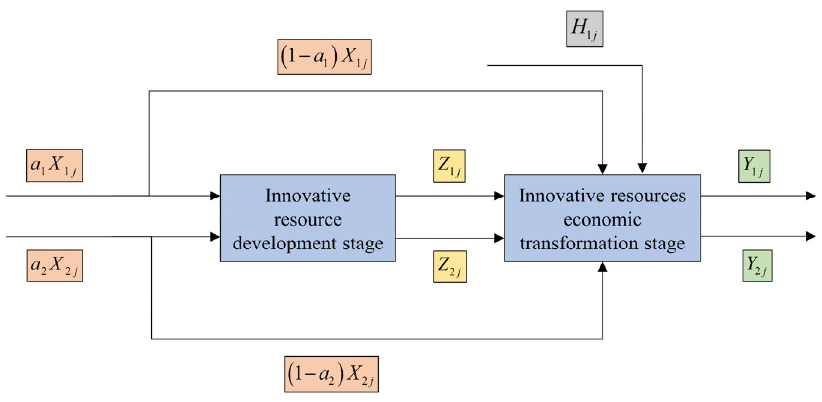
Figure 1. Network DEA model based on resource sharing and two-stage additional input.